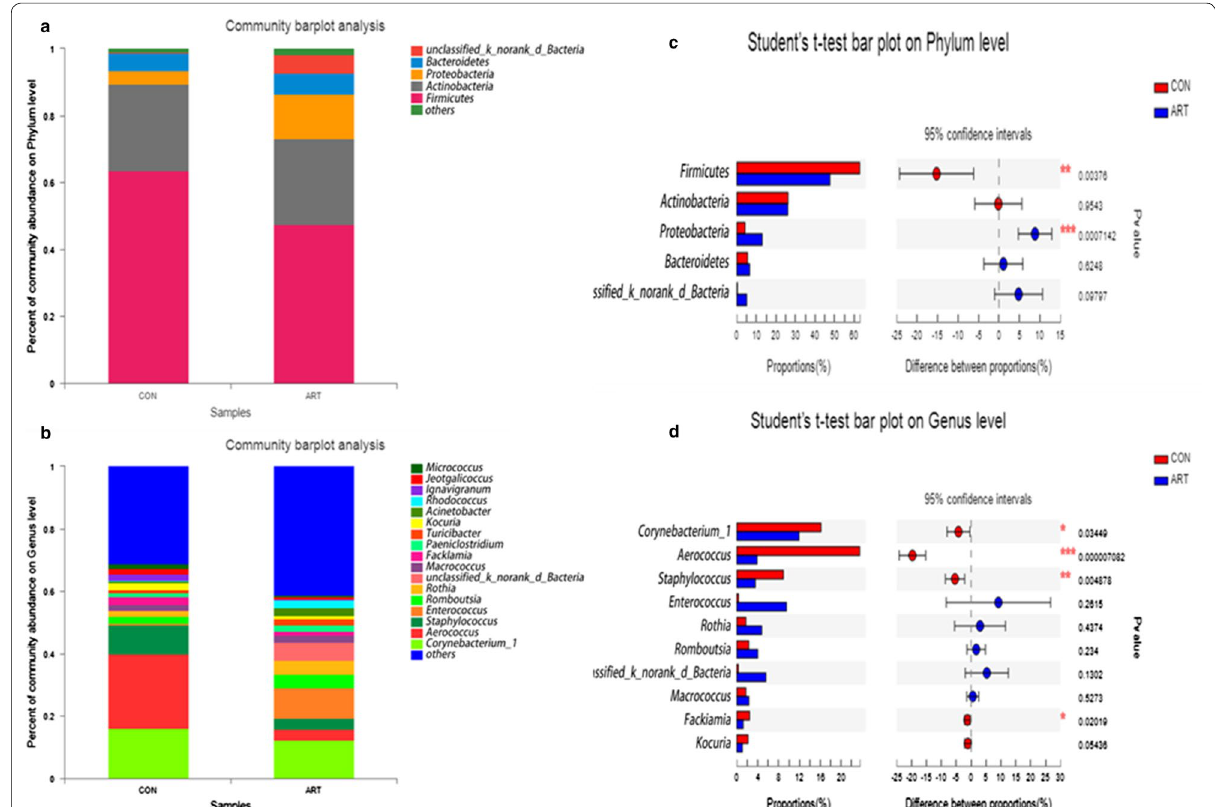
Fig. 2 Predominant bacteria in milk samples from lactating cows fed TMR supplemented with 0 (CON) and 120 g/d artemisinin (ART), n a Phylum level. b Genus level. c Significant differences in bacteria at the phylum level in milk samples between the two groups. d Significant differences in bacteria at the genus level in milk samples between the two groups. The extended error bar plot was generated using STAMP software. Welch’s two-sided test was used, and Welch’s inverted confidence interval was 0.95